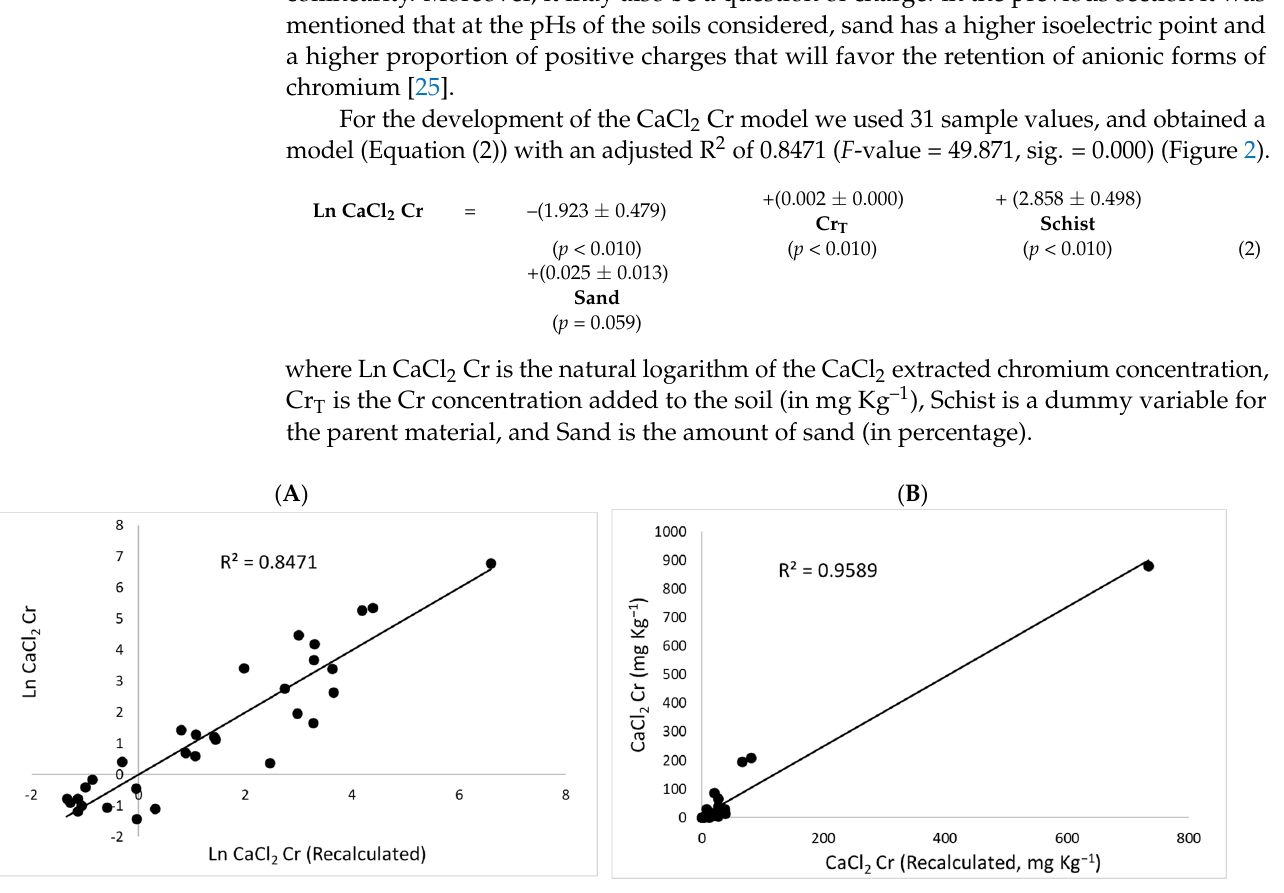
Figure 2. Goodness of fit for measured and recalculated fractions of CaCl 2 Cr in ( A ) logarithmic scale and in ( B ) mg Cr Kg –1 of soil.